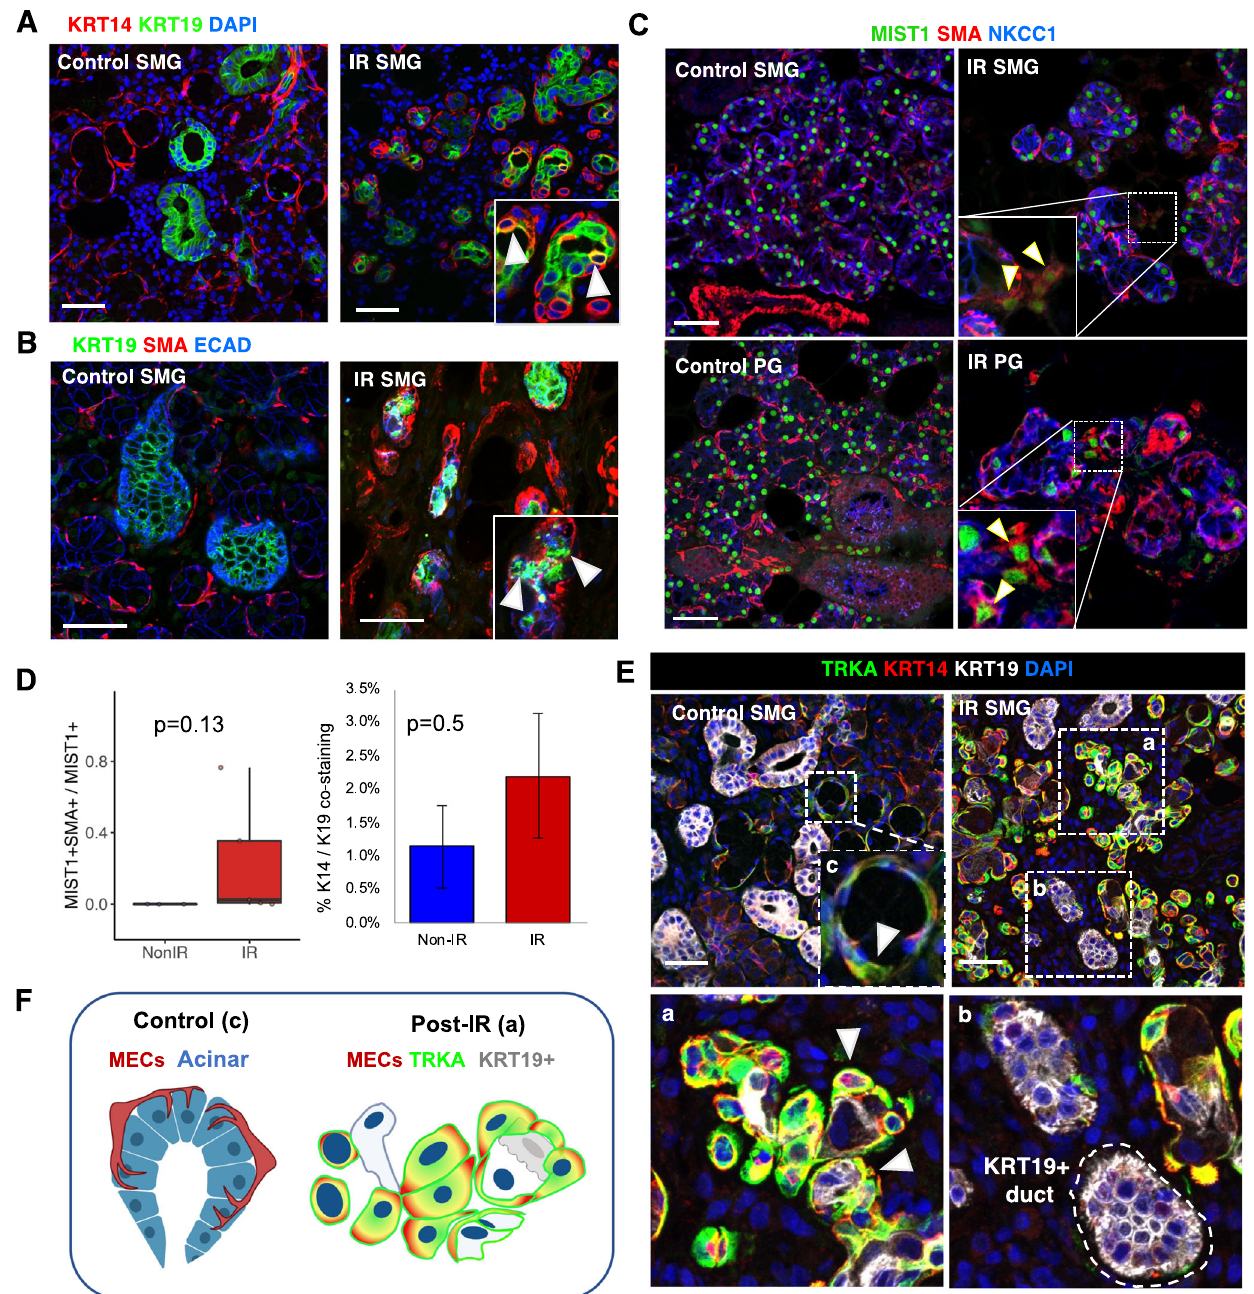
Fig. 7 Upregulation of NTRs is directly associated with abnormal morphology and co-expression of MIST1 and KRT19 in MECs post-IR in humans. A Control and IR SMG stained for KRT14 (red), KRT19 (green), and DAPI (blue). White arrows point at cells with overlap between KRT14 and KRT19. Scale bars, 50 µm. B Control and IR SMG glands immunostained for KRT19 (green), SMA (red), and E-cadherin (blue). C Control and IR SMG and PG glands stained for MIST1 (green), SMA (red), and NKCC1 (blue). White arrows point at cells with overlap between SMA and MIST1. Scale bars, 50 µm. D Quanti fi cation of double-positive MIST1 + /SMA + cells normalized to number of MIST1 + , and %SMA/K19 co-localization from IF staining ( n = 3 PG IR, 2 PG non-IR, 4 SMG IR, 1 SMG non-IR). E Immunostaining of human SMG for KRT14 (Red), KRT19 (white), and TRKA (green). Delineated areas are expanded and denoted by labels ‘ a ’ , ‘ b ’ and ‘ c ’ . White arrows point at representative MECs. All scale bars, 50 µm. F Representation of morphological differences between control and IR